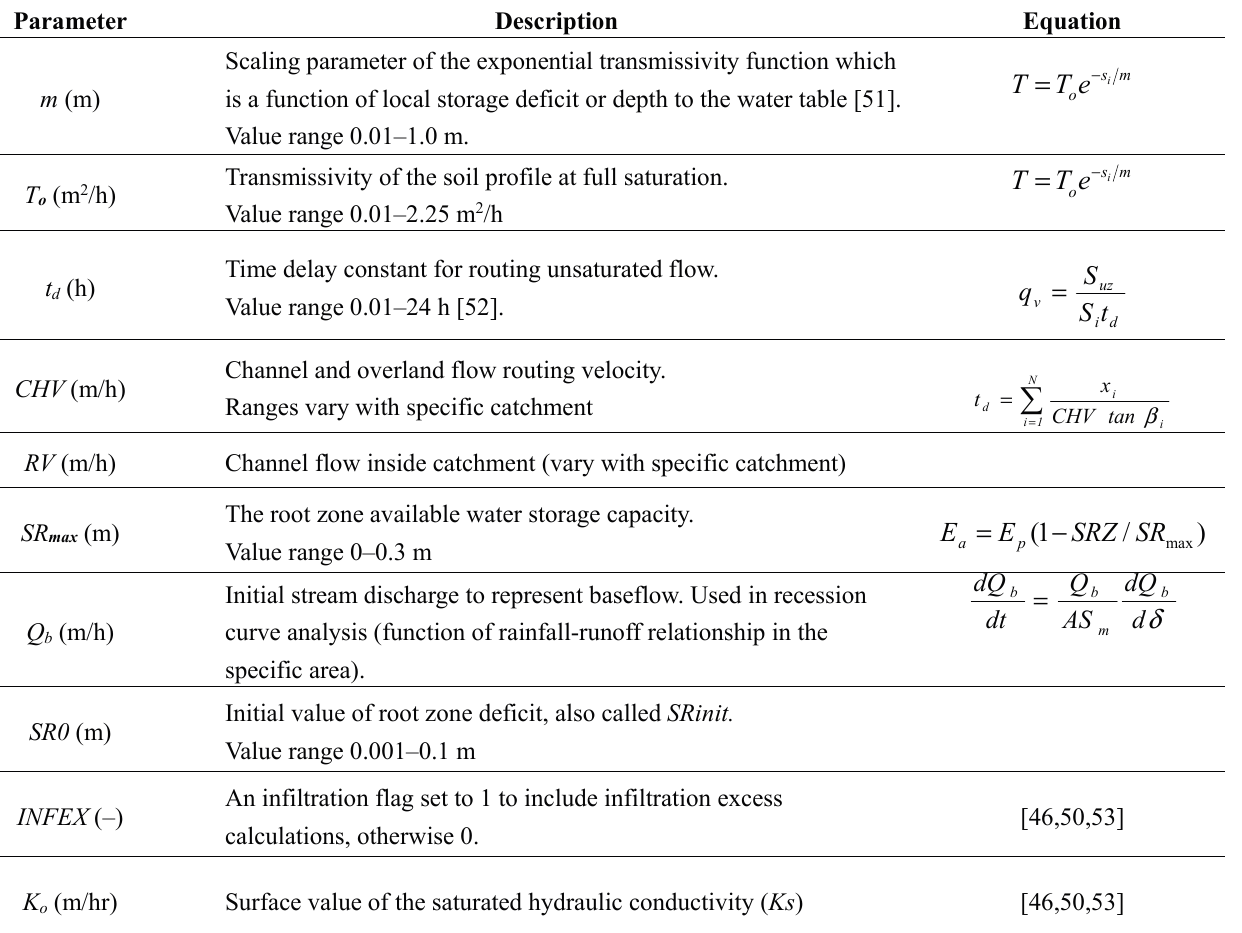
Table 5. TOPMODEL